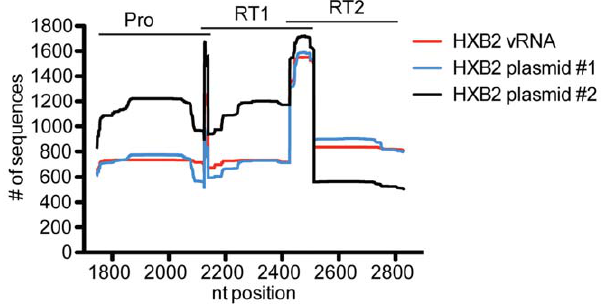
Figure 2. Sequence coverage of three amplicons from a clonal HXB2 viral stock and HXB2 plasmid. The number of sequences from the clonal viral stock (red) or HIV plasmid (blue and black) that aligned to each nucleotide position of the NC_001802 HXB2 HIV reference sequence is shown across the pol gene. The HXB2 vRNA clonal viral stock was sequenced under one GS Junior sequencing run, while two independent PCR amplifications were used to sequence the plasmid under two different MID tags in a separate GS Junior sequencing run. Pyrosequencing was performed on three overlapping amplicons with nucleotide positions for each amplicon represented at the top of the graph.